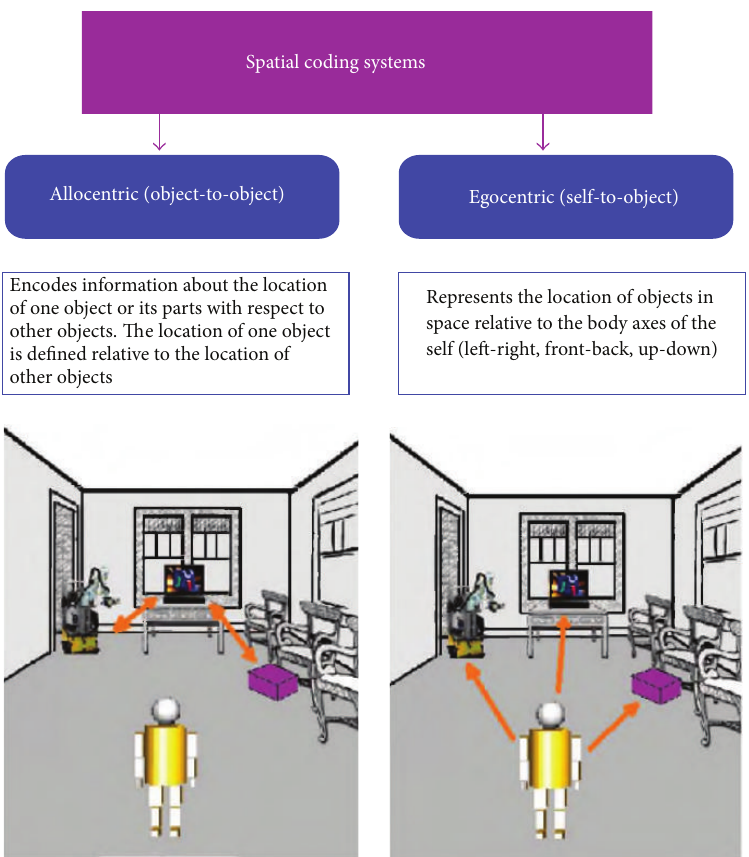
Figure 1: Allocentric versus egocentric spatial processing. Allocentric spatial transformations involve an object-to-object representational system and encode information about the location of one object or its parts with respect to other objects, while egocentric perspective transformations involve a self-object representational system.